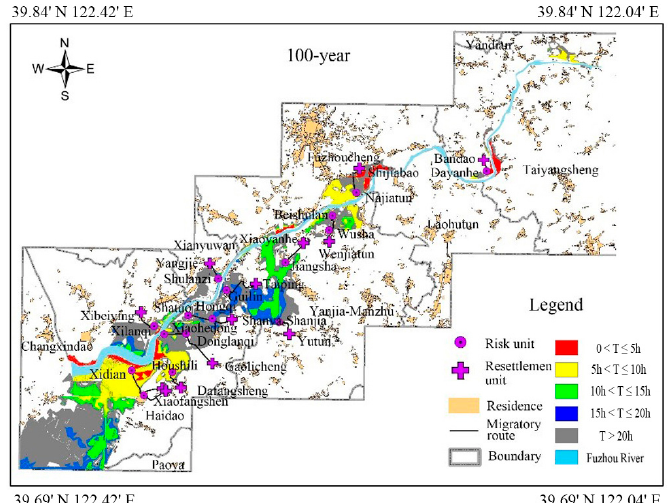
Figure 18. Evacuation plan of 100-year return period scenario.